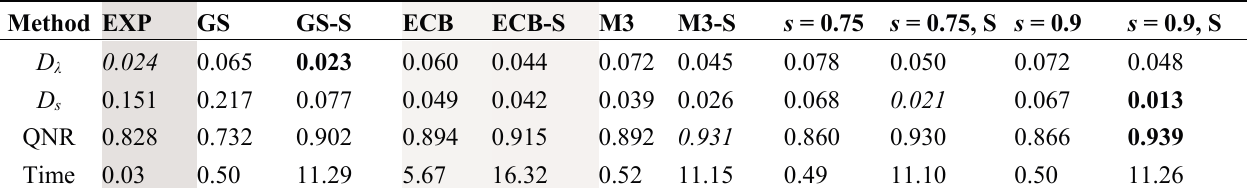
Table 12. Quantitative comparison of the fusion results to check Alparone’s protocol for the WorldView-2 group 2 dataset at full scale, i.e ., at 0.5 m. Time is measured in minutes. The font face indicators are identical to those in Table